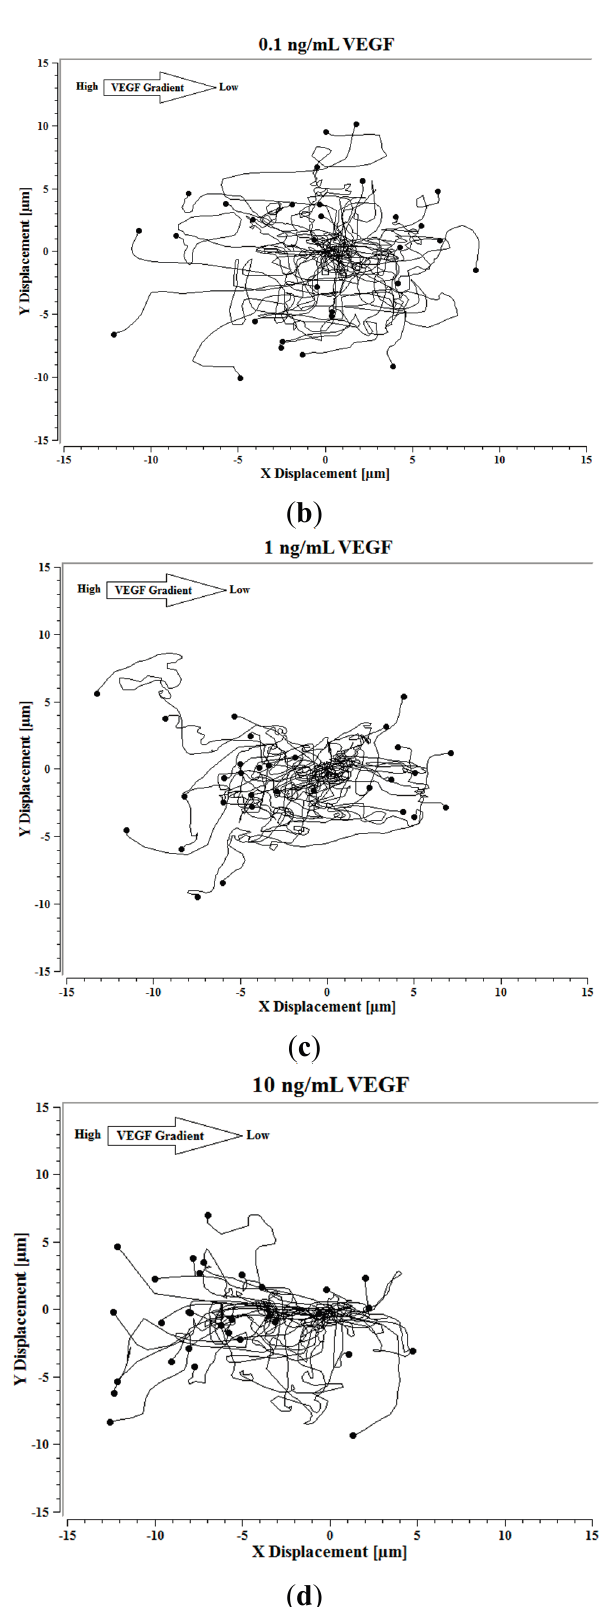
Figure 4. ( a ) Baseline motility and cell paths for P. aeruginosa BK-76 cells. Motility and cell paths of P. aeruginosa BK-76 cells in a 0.1 ( b ), 1 ( c ), and 10 ng/mL ( d ) vascular endothelial growth factor (VEGF) concentration gradients respectively. For context, the VEGF concentration gradient (from high to low) runs from left to